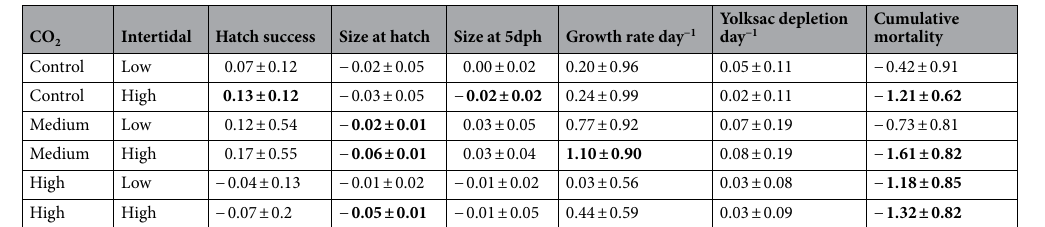
Table 3. Mean effect size (lnRR) ± 95% confidence interval of low (2 × 2 h air exposure day −1 ) and